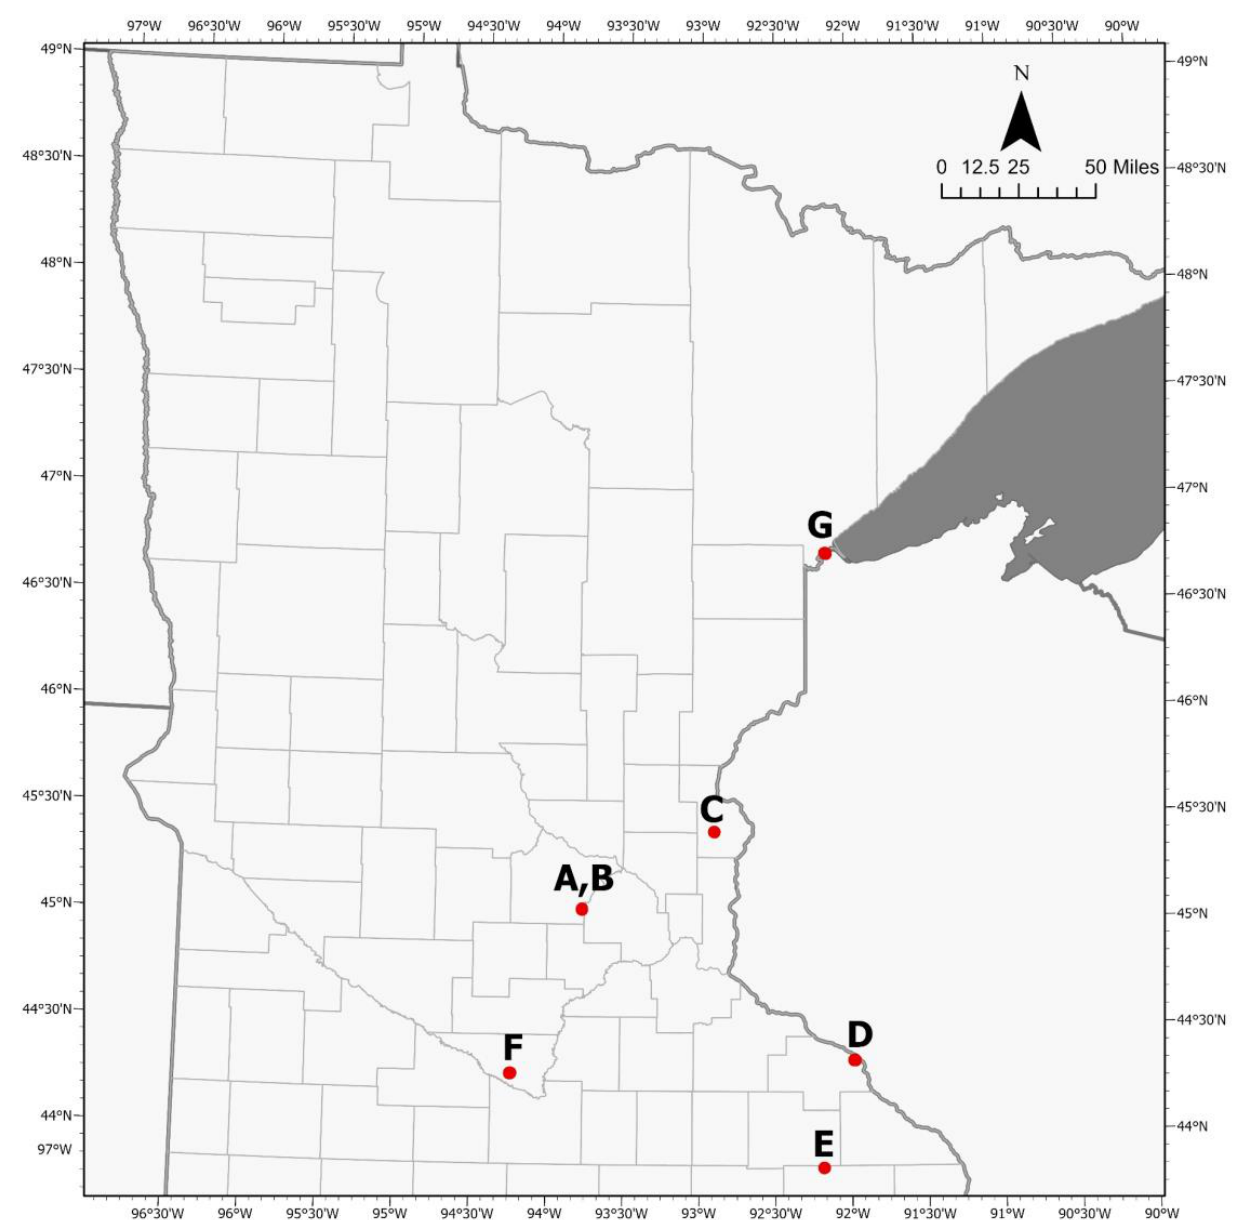
Figure 1. Study sites located in Minnesota, USA: (A) Delano wastewater treatment facility, (B) Delano City Park, (C) Chisago City, (D) Wabasha, (E) Chatfield wastewater treatment facility, (F) Swan Lake Wildlife Management Area, and (G) Grassy Point Park.